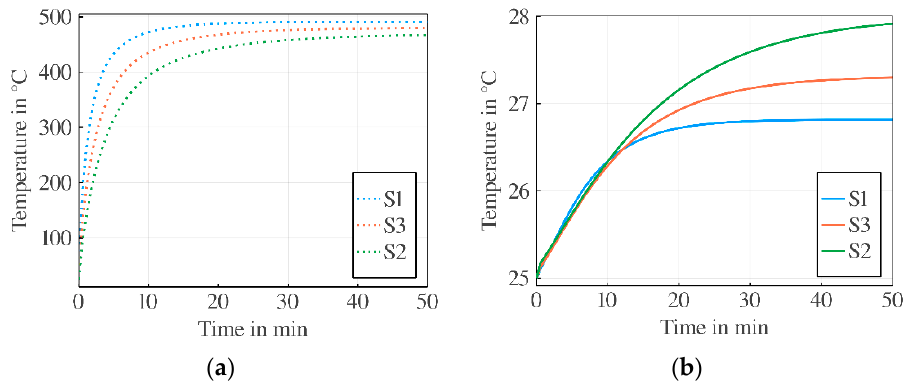
Figure 10. Simulated preheating temperature of scrap ( a ) and off-gas outlet temperature ( b ) over process time of phase 1 for the different characteristic scrap parts S1, S2 and S3 (see Table 1).